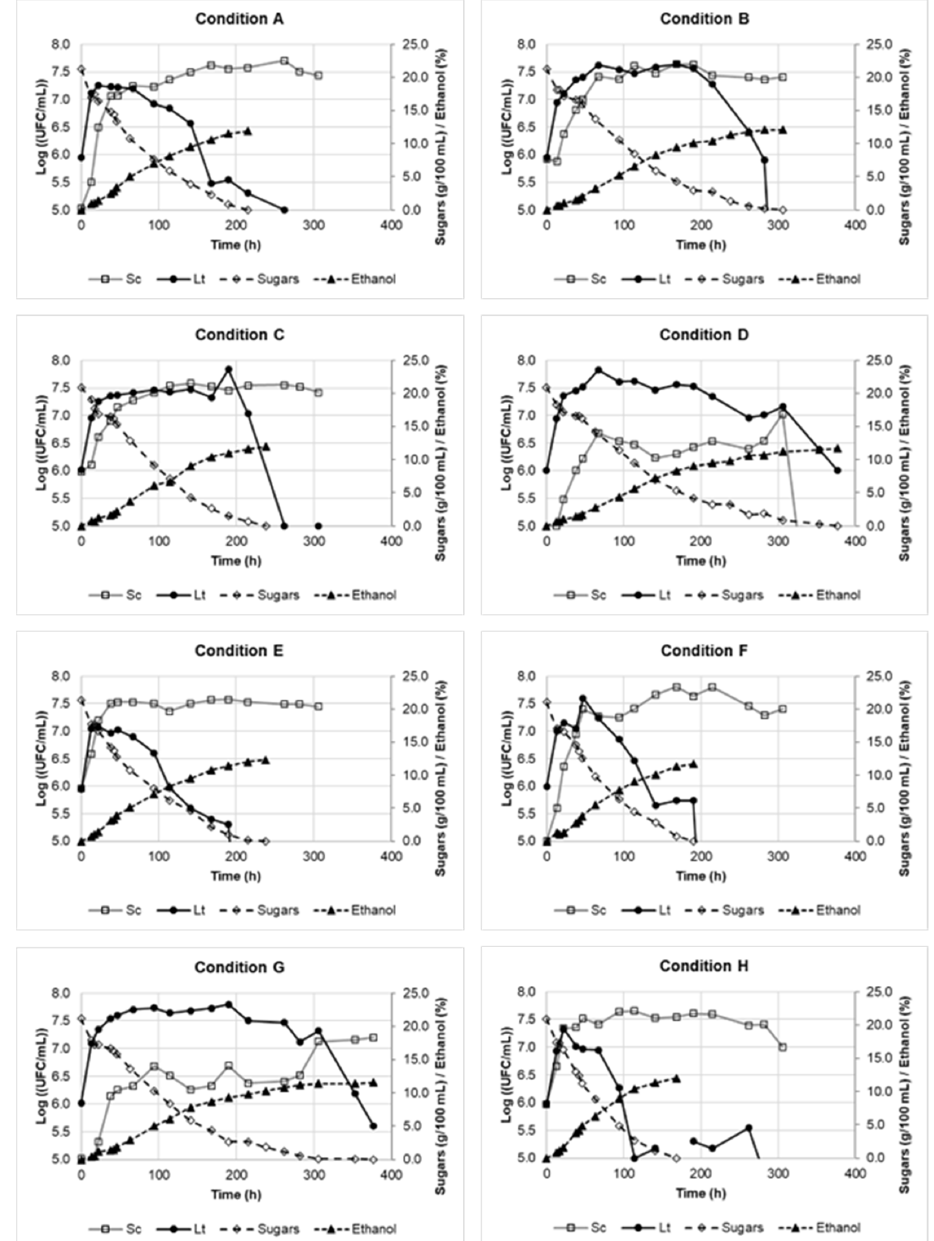
Figure A1. Evolution of both yeast populations, sugar concentrations, and ethanol concentrations during coculture of S. cerevisiae and L. thermotolerans in the different conditions of the experimental design ( A – H ).